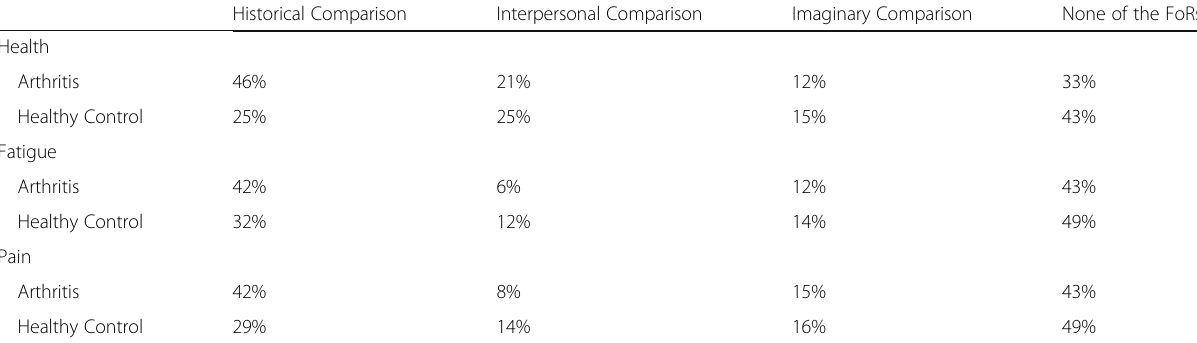
Table 2 Use of Historical, Interpersonal, and Imaginary c omparisons in people with arthritis and healthy controls Historical Comparison Interpersonal Comparison Imaginary Comparison None of the FoRs